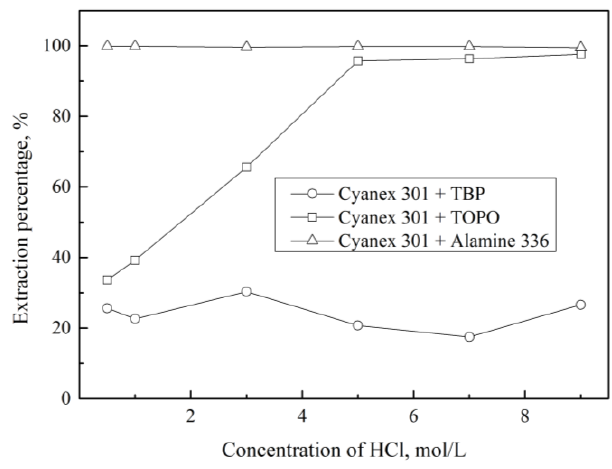
Figure 2. Effect of HCl concentration on extraction of Pd(II). Aqueous: [Pd] = 100 mg/L, [HCl] = 0.5–9 mol/L. Organic: 0.01 mol/L Cyanex 301 + 0.1 mol/L TBP, 0.01 mol/L Cyanex 301 + 0.01 mol/L TOPO, 0.01 mol/L Cyanex 301 + 0.02 mol/L Alamine 336. O/A = 1. Diluent: kerosene.